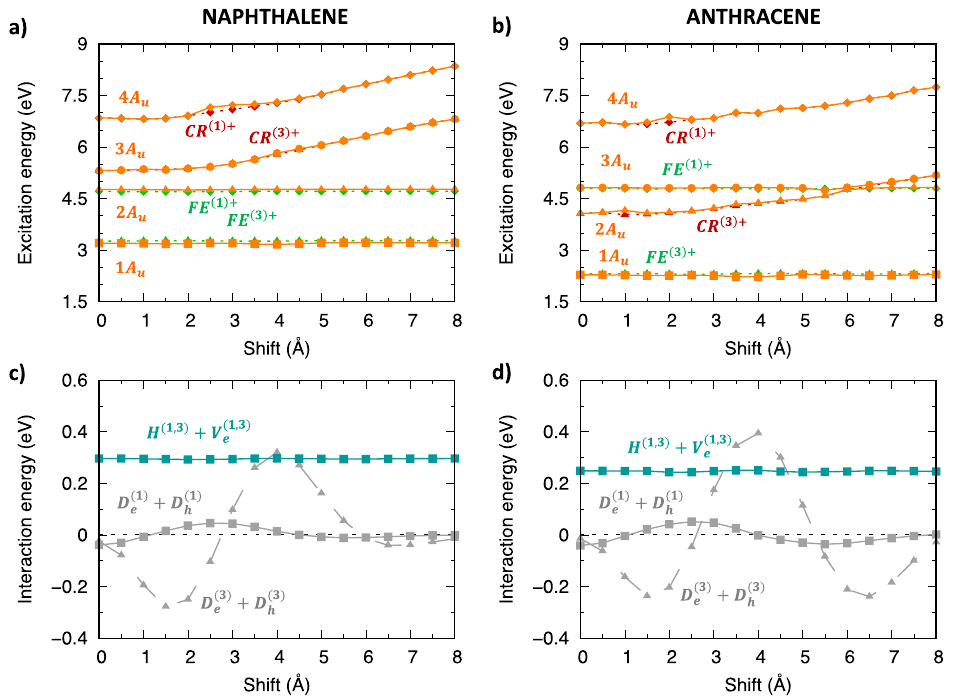
Figure 10. Analysis of the excitation energy profiles of triplet exciton states ( 𝐴 𝑢 symmetry) for (left) naphthalene and (right) anthracene dimer (TDA- ωB97X -D/6-31G * ) in terms of SA diabatic states (green for 𝐹𝐸 states, red for 𝐶𝑅 states) and their interactions. (a, b) Computed adiabatic and SA diabatic excitation energy profiles. (c, d) Magnitude and modulation along the longitudinal translation coordinate of the (grey) 𝐷 𝑒(1) + 𝐷 ℎ(1) , 𝐷 𝑒(3) + 𝐷 ℎ(3) interactions, coupling 𝐹𝐸 and 𝐶𝑅 states, and of the (dark-turquoise) 𝐻 (1,3) + 𝑉 interactions mixing 𝐹𝐸 (1) and 𝐹𝐸 (3) states.